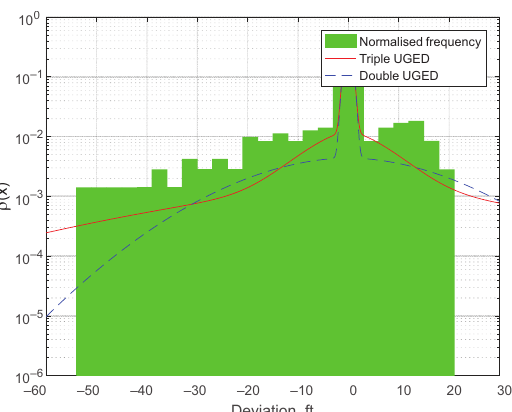
Figure 4. TUGED for 5/23 runway statistics